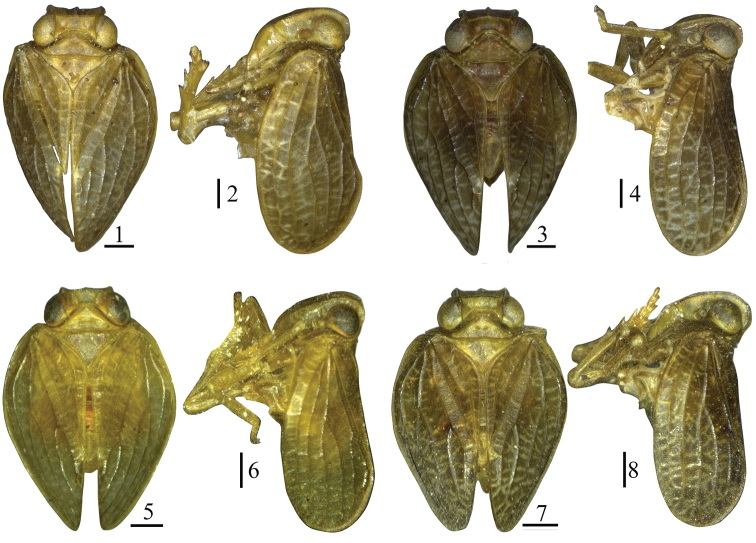
Habitus of Sinonissus species. 1, 2Sinonissus
brunetus Wang, Shi & Bourgoin, 2018 3, 4Sinonissus
daozhenensis Chang & Chen, sp. nov. 5, 6Sinonissus
hamulatus Chang & Chen, sp. nov. 7, 8Sinonissus
longicaudus Chang & Chen, sp. nov. Scale bars: 0.5 mm.